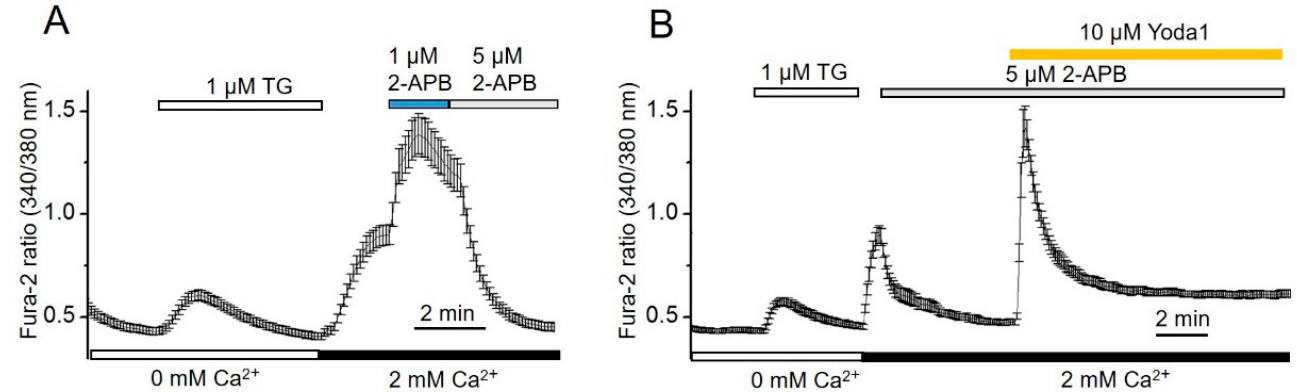
Figure 4. 2-APB suppresses the store-operated Ca 2+ entry and abrogates the second (delayed) phase of Yoda1-induced Ca 2+ increase in eMSCs. ( A ) Shown are typical Ca 2+ responses from the representative experiment ( n = 4) following the 1 µ M and 5 µ M 2-APB application on eMSCs. Measurements were performed in individual cells with the imaging system. [Ca 2+ ] i is plotted versus time. Each point is a mean ± SD from 17 cells. ( B ) 2-APB suppresses both SOCE and the delayed phase of Piezo-mediated Ca 2+ entry in eMSCs. Each point is a mean ± SD from 13 cells.